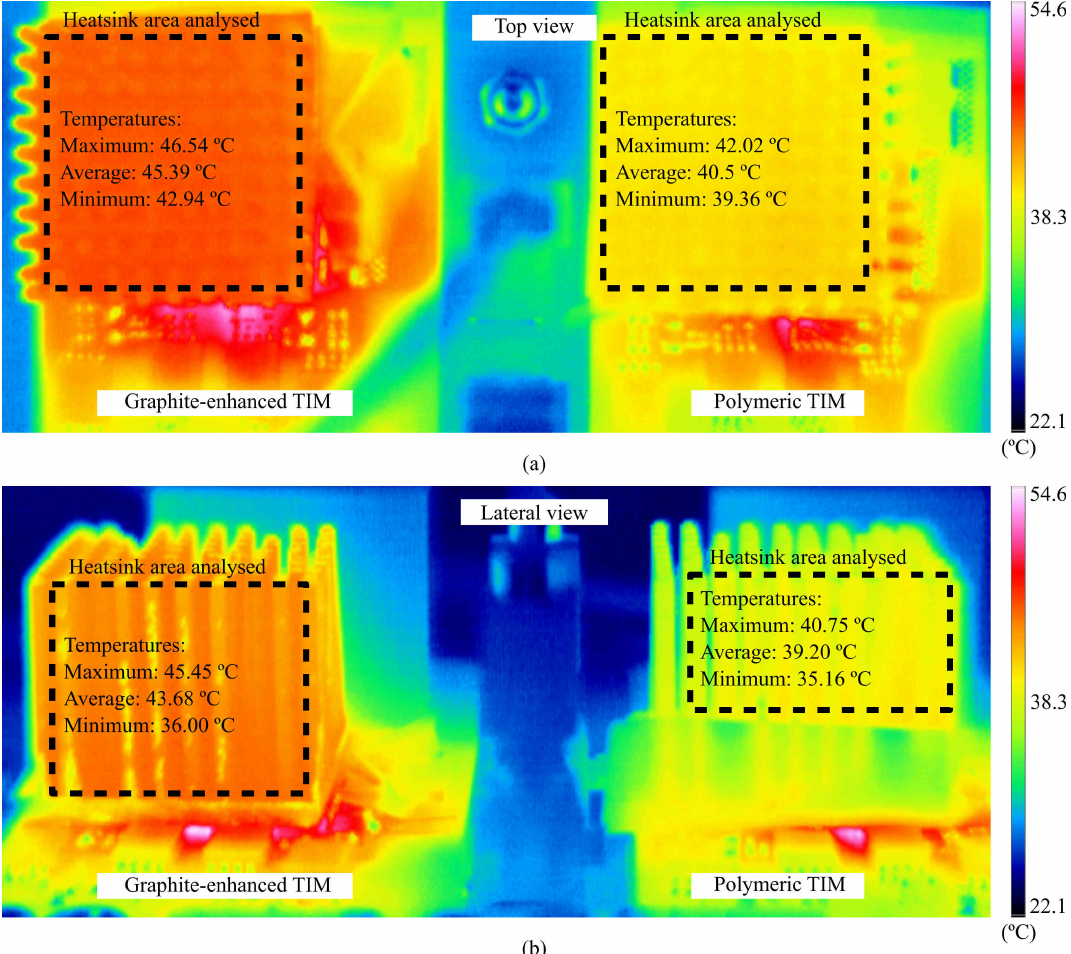
Figure 23. Thermal images of the top-side cooled converter: ( a ) top view and ( b ) lateral